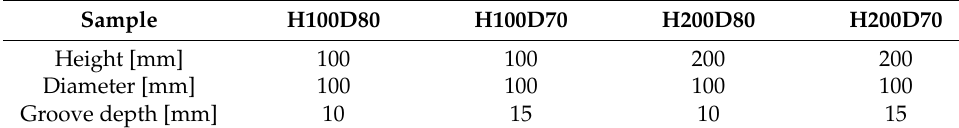
Table 3. Geometries of the mechanically grooved concrete cylinders. Sample